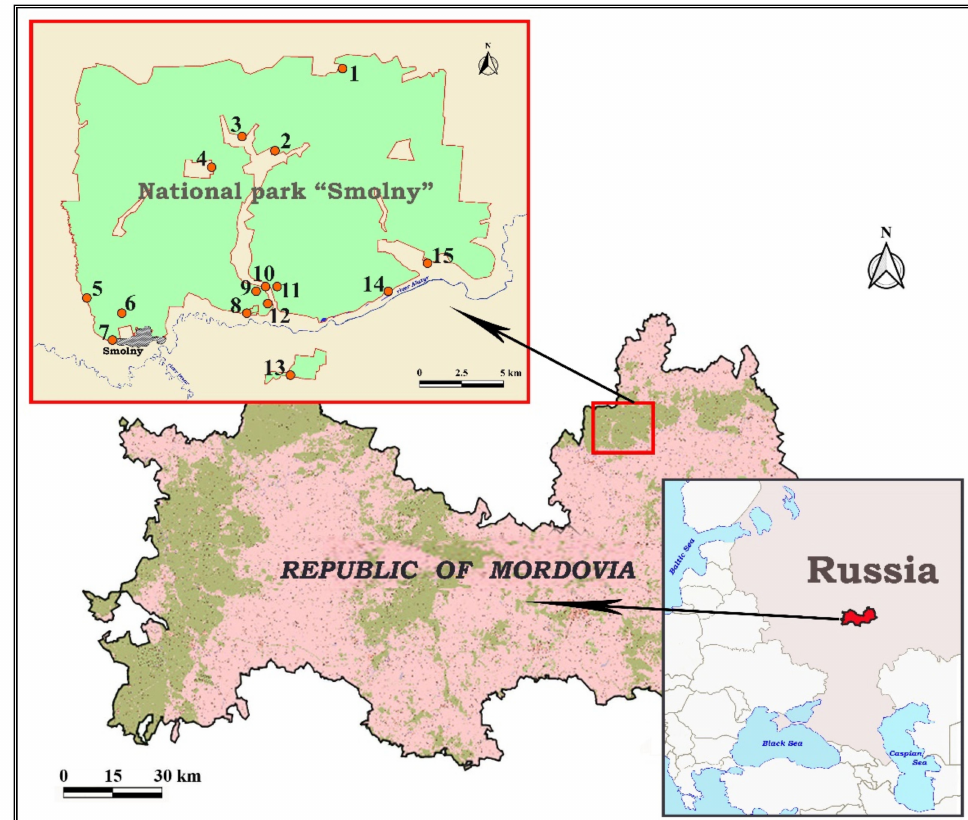
Figure 1. A schematic map of rodent trapping stations in the National Park “Smolny”. Red circles in the map showed the rodent trapping places. 1—Lesnoy village, 2—Orlovo Gnezdo site,